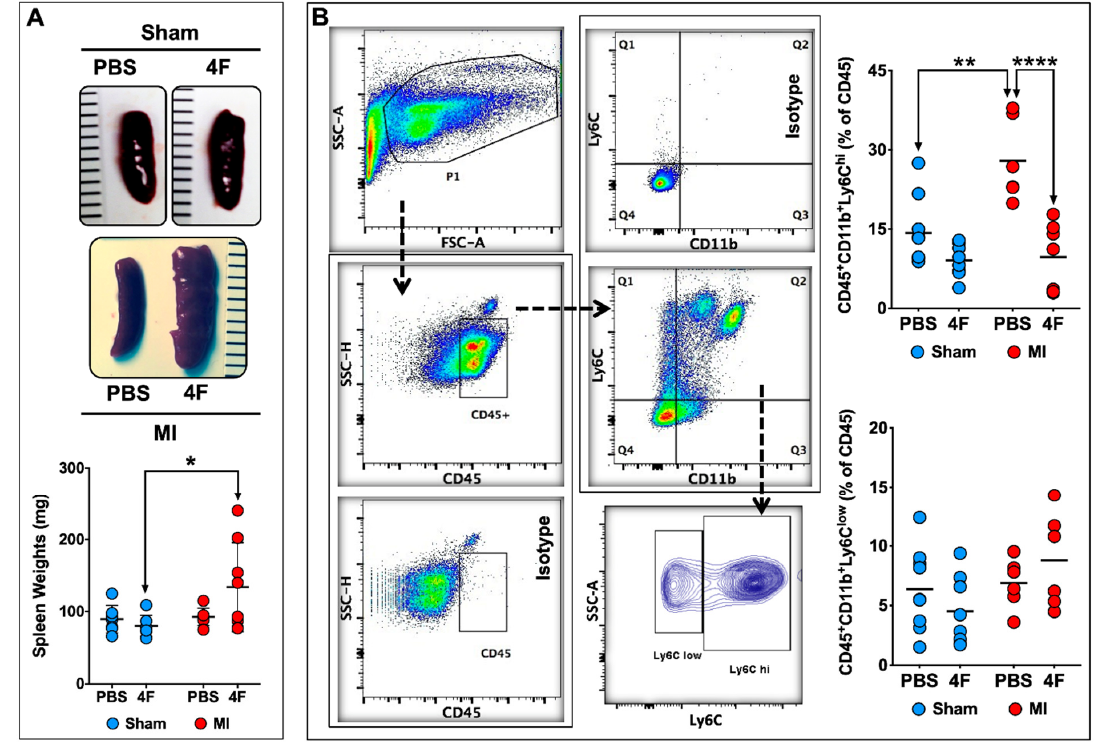
Figure 3. L-4F suppresses levels of pro-inflammatory splenic monocytes post-MI. ( A ) Representative gross images of spleens harvested from sham-operated or MI mice injected with either PBS or L-4F (100 µ g / day) for 5 days starting at day 3 post-surgery, and the corresponding gravimetric quantitation. ( B ) Gating strategy and group data for flow cytometric quantitation of splenic monocytes following L-4F or PBS treatment. Splenic pro-inflammatory and patrolling monocytes were identified as CD45 + CD11b + Ly6C hi and CD45 + CD11b + Ly6C low cells, respectively. Data are depicted as percent of CD45 + cells, n = 5–8 / group. ** p < 0.005, **** p < 0.0005.